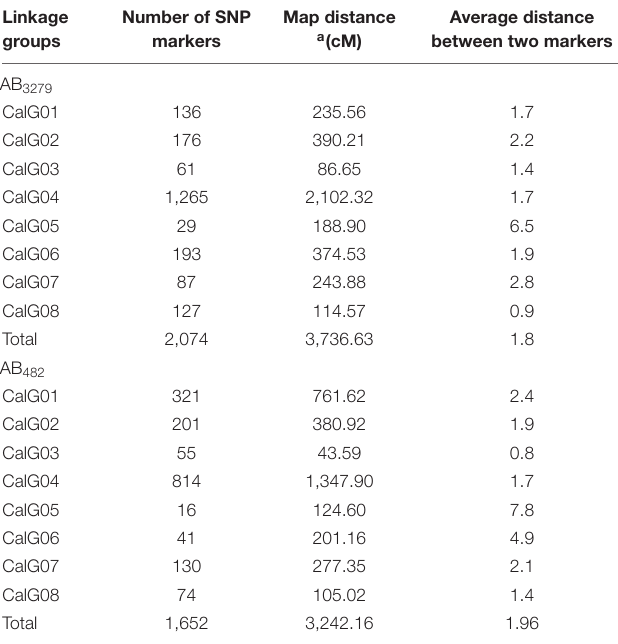
TABLE 3 | Distribution of markers on the intra-specific genetic map based on both chickpea RIL populations AB 3279 and AB 482 . Linkage Number of SNP groups markers ( Table 5 ). AB 3279 -LG4-QTL-3, identified in KHS-18, spanned